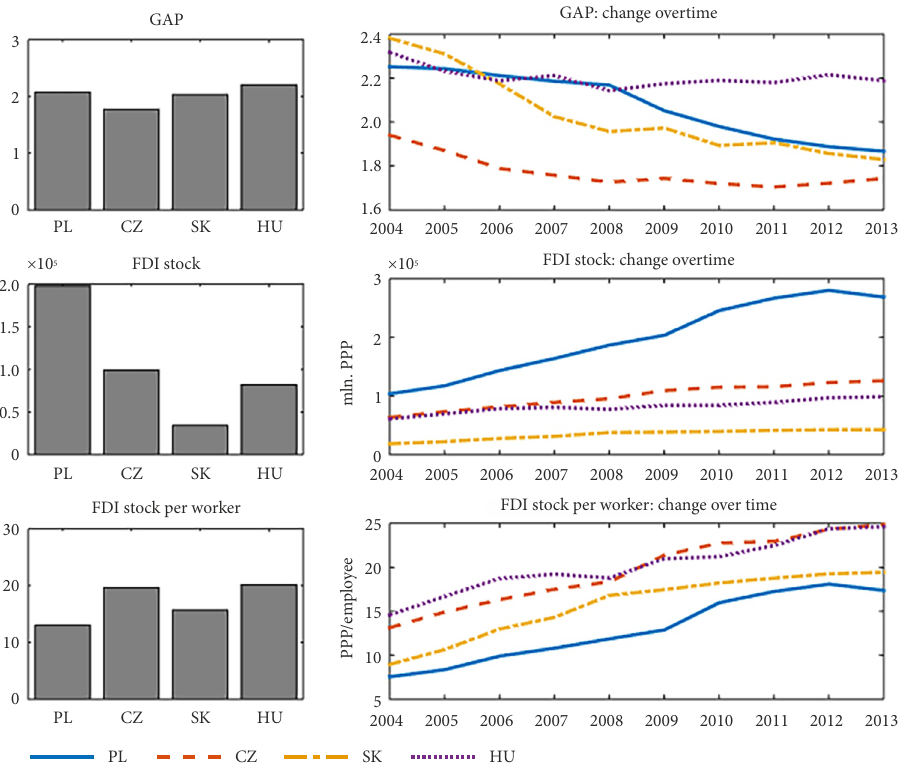
Figure 1. Basic trends in FDI and GAP in the Visegrad countries in 2004–2013